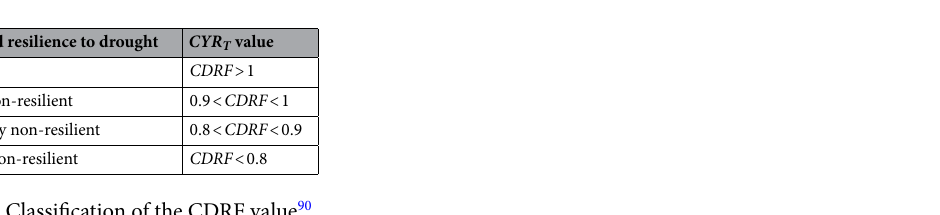
Table 3. Classification of the CDRF value 90